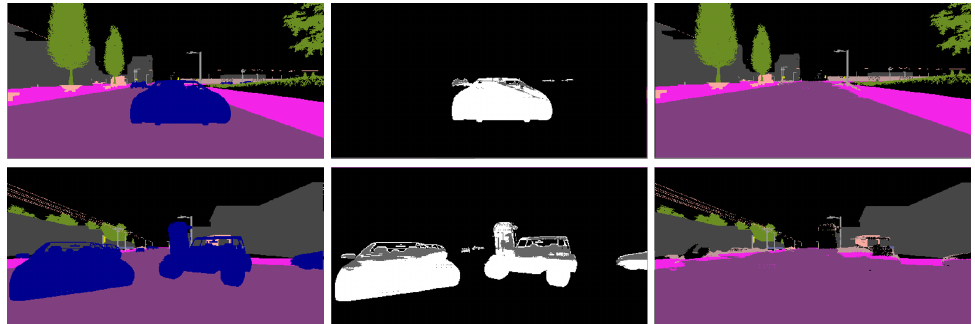
Figure 2. Removing the dynamic objects at the segmentation map using the purposed method: left : input (dynamic segmentation map); center : dynamic object mask; right : output (inpainted segmentation